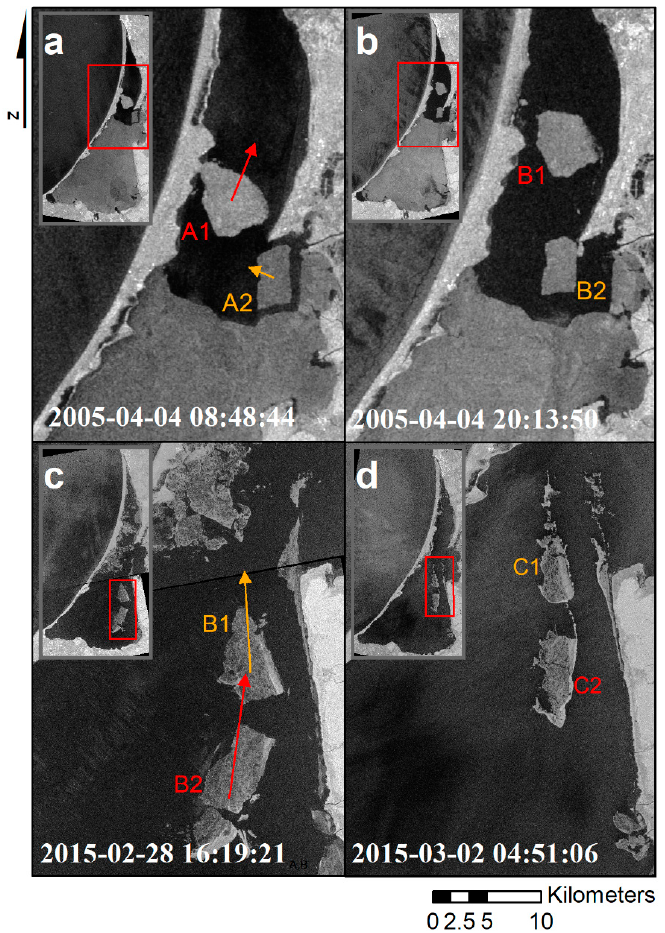
Figure 5. Examples of the ice drift in the Curonian Lagoon observed in the SAR images. Envisat ASAR images of the two ice floes in the Lithuanian part of the Curonian Lagoon taken on 4 April 2005 at 8:48:44 UTC ( a ) and at 20:13:50 UTC ( b ). Sentinel-1A images of the ice floes in the Russian part of the lagoon acquired on 28 February 2015 at 16:19:21 UTC ( c ) and 2 March at 04:51:06 UTC ( d